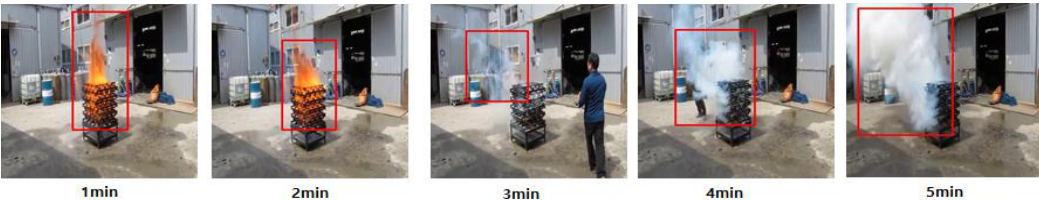
Figure 13. Sample still shots of the video clip shown in the first row and first column.